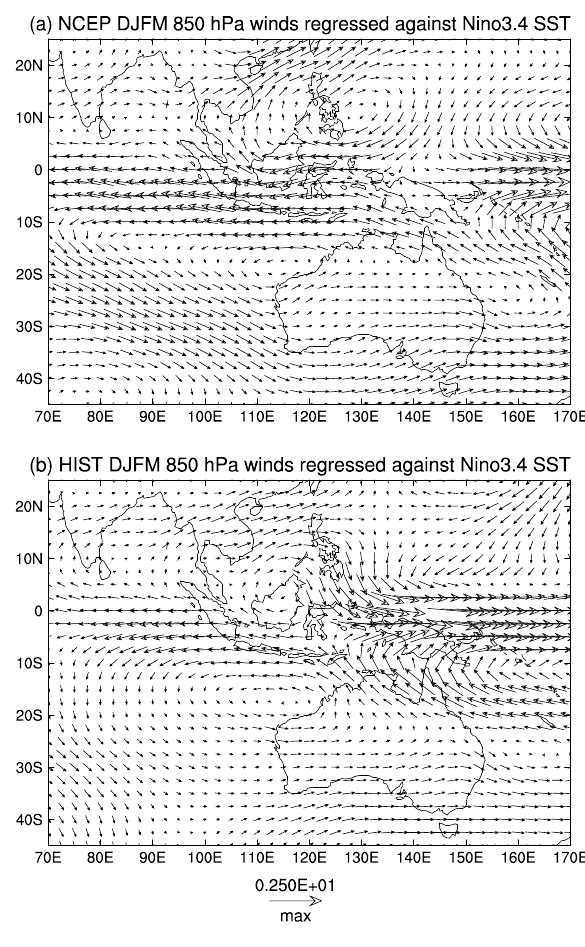
Fig. 7. DJFM 850hPa winds regressed against Ni˜no-3.4 SST (ms − 1 K − 1 ) for the period 1951–2010, from (a) observations (HadISST and NCEP), and (b) the HIST ensemble. All data sets were linearly detrended before performing the